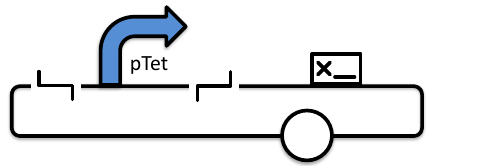
Figure 29: Promoter pTet stored in a circular plasmid. The promoter is prepared for being cut out of the plasmid: it is preceded by a 5’ sticky end restriction site and followed by a 3’ stick end restriction site. In addition, the plasmid has been bar-coded with a signature and has its origin of replication marked.